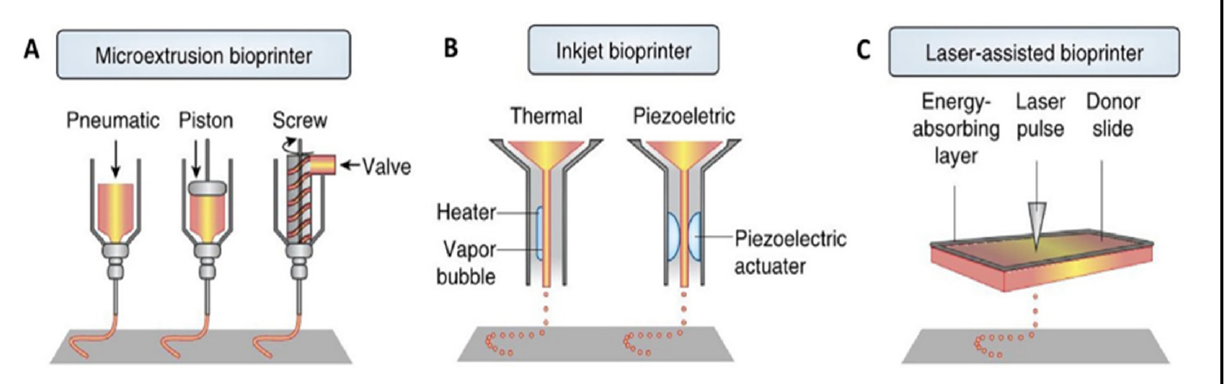
Figure 1. Visual representation of extrusion ( A ), inkjet ( B ), and laser-assisted ( C ) bioprinters. Extru- sion bioprinter ( A ) can have pneumatic, piston, or screw-driven pressure. Inkjet bioprinter ( B ) can be thermal or piezoelectric. Reproduced with permission [15].